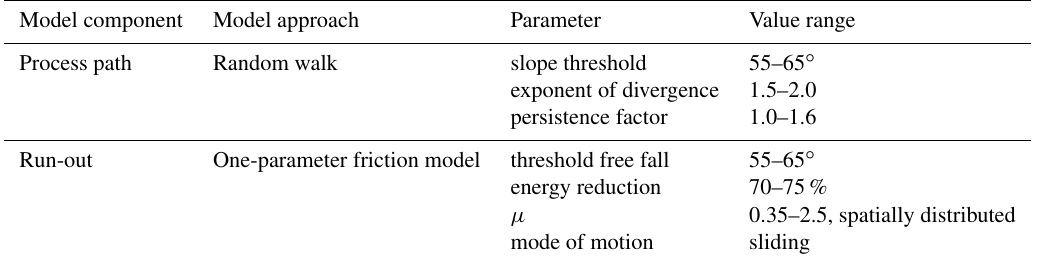
Table 1. Model configuration for rockfall modeling on a regional scale and approximate parameter ranges (compiled from Wichmann, 2006; Wichmann and Becht, 2006; Proske and Bauer, 2016).